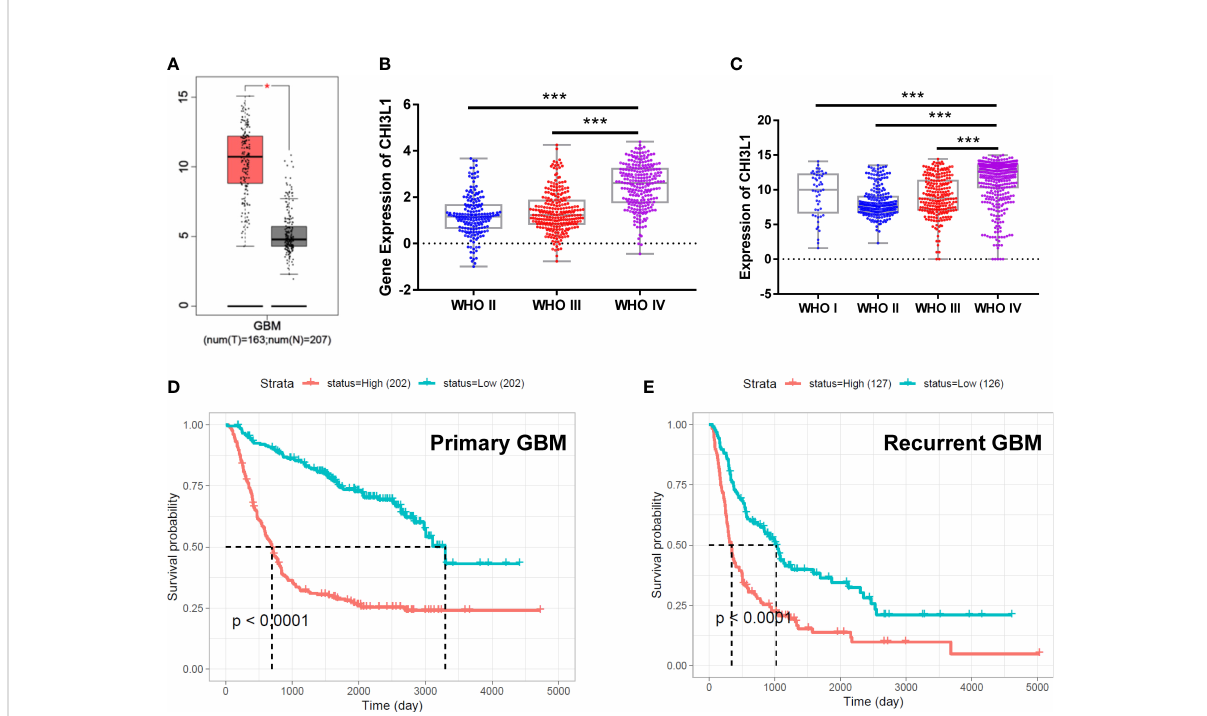
FIGURE 1 The expression of CHI3L1/YKL-40 is upregulated in GBM cases with poor prognosis. (A) YKL-40 expression is upregulated in GBM patients compared with normal samples based on data from the GEPIA database (tumor tissue in red box, normal tissue in gray box, *p<0.05). (B, C) In data from the CGGA and GENT databases, YKL-40 mRNA levels were positively associated with the histological grade of the glioma (***p<0.001) (D, E) Kaplan-Meier curve of the probability of survival in primary (D) or recurrent GBM (E) by difference in the expression of YKL- 40, based on data adopted from the CGGA